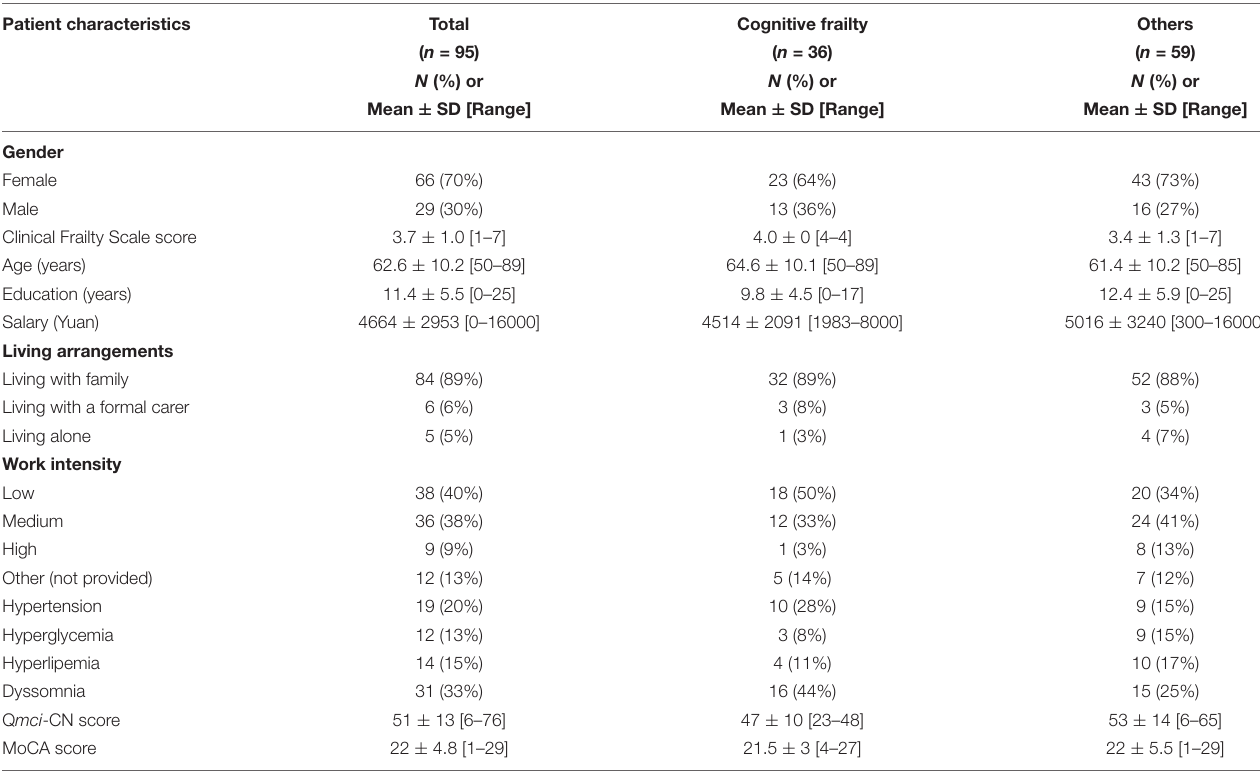
TABLE 1 | Characteristics of patients included ( n = 95).